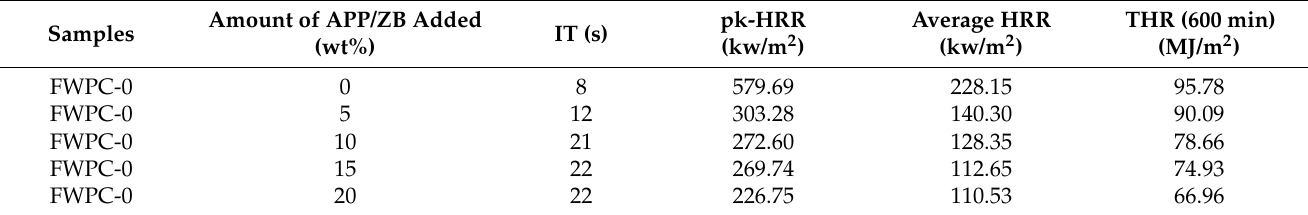
Table 4. Important parameters of cone calorimetry test for flame-retardant